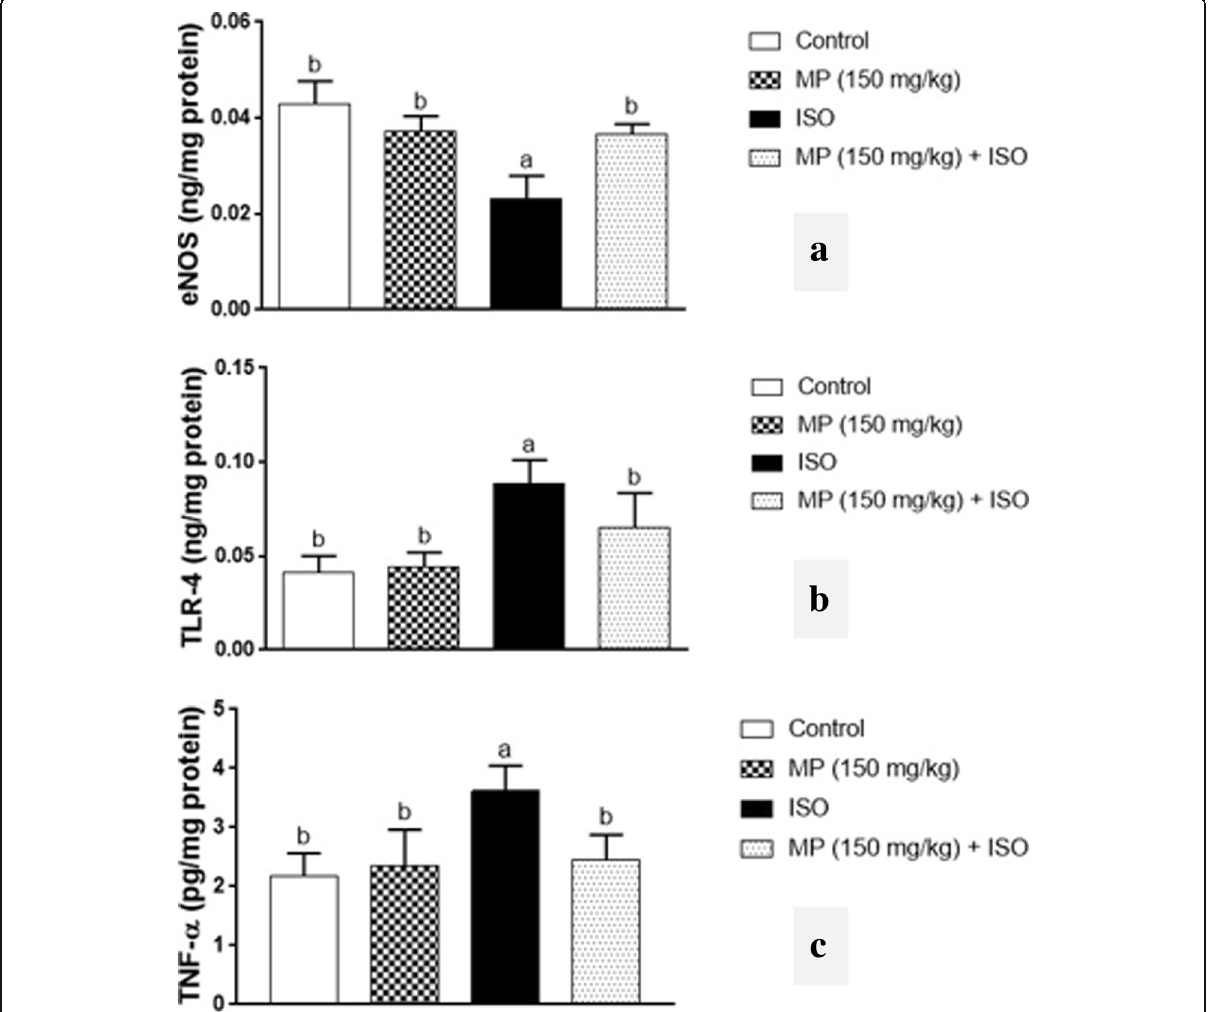
Fig. 7 Effect of MP (150 mg/kg) on cardiac content of eNOS, TLR-4, and TNF- α in ISO-intoxicated rats. a eNOS. b TLR-4. c TNF- α . Rats were pretreated with MP (150 mg/kg, p.o) three times per week on alternating days for 2 weeks and then injected with 2 consecutive doses of ISO (85 mg/kg, s.c) on the 13th and 14th days. Data are presented as mean ± SD ( n = 7); a or b: significantly different from control or ISO groups respectively at P < 0.05 using one-way ANOVA followed by Tukey as a post hoc test. MP methyl palmitate, ISO isoproterenol, eNOS